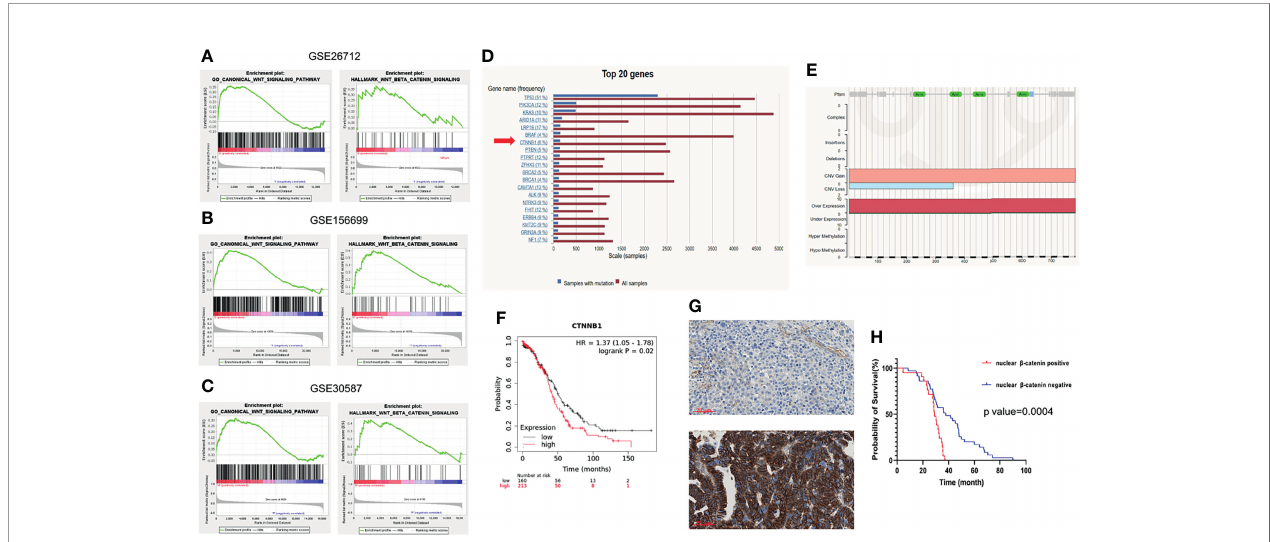
FIGURE 1 | Wnt/ b -catenin pathway in ovarian cancer progression. GSEA was performed using the GSEA tool provided by the Broad Institute (http://software.broadinstitute. org/gsea). Enriched plots were generated to compare the expression of a set of genes in GO canonical Wnt signaling and Hallmark Wnt/ b -catenin signaling between different groups of datasets (X axis means the gene hits and Y axis means the enrichment score. Red part means genes that positively correlated with the pathway and blue part means genes that negatively correlated with the pathway). (A) The gene expression pro fi ling of 185 primary ovarian cancer tissues was included in GSE26712 dataset. Samples were divided according to the overall survival (OS) of patients into the long (OS >= 36 months) and short survival group (OS < 36 months). Wnt/ b -catenin pathway was shown to be enriched in the short OS group than the long OS group by GO analysis (left) and Hallmark analysis (right). (B) The gene expression pro fi ling of 88 high-grade serous ovarian cancer tissues was included in GSE156699 dataset. Samples were divided into the chemotherapy responder group and non-responder group according to patients ’ response to chemotherapy. Wnt/ b -catenin pathway was enriched in the chemotherapy non-responder group by GO analysis (left) and Hallmark analysis (right). (C) The gene expression pro fi ling of 18 paired ovarian cancer primary tissues and omental metastases was included in GSE30587 dataset. Wnt/ b -catenin pathway was enriched in omental metastases than primary sites by GO analysis (left) and Hallmark analysis (right). (D) Top 20 frequently mutated genes were listed in ovarian cancer in COSMIC (https://cancer.sanger.ac.uk/cosmic/). Among these, CTNNB1 mutation frequency accounted for 6% among all ovarian cancer patients. (E) Most of the CTNNB1 mutation types were copy number variation (CNV) gain or gene overexpression. CTNNB1 expression was negatively related to the overall survival of ovarian cancer patients by Kaplan- Meier Plotter (https://kmplot.com/analysis/). Nuclear b -catenin expression was signi fi cantly associated with the survival of ovarian cancer patients (F) . Nuclear b -catenin expression was assessed using the high-grade serous ovarian cancer tissue microarray (N=56). Samples were scored as negative (above) or positive (below) according to the b -catenin staining intensity in the nucleus (G) . (H) The positive nuclear b -catenin expression was correlated with a worse overall survival (Log-rank test, p